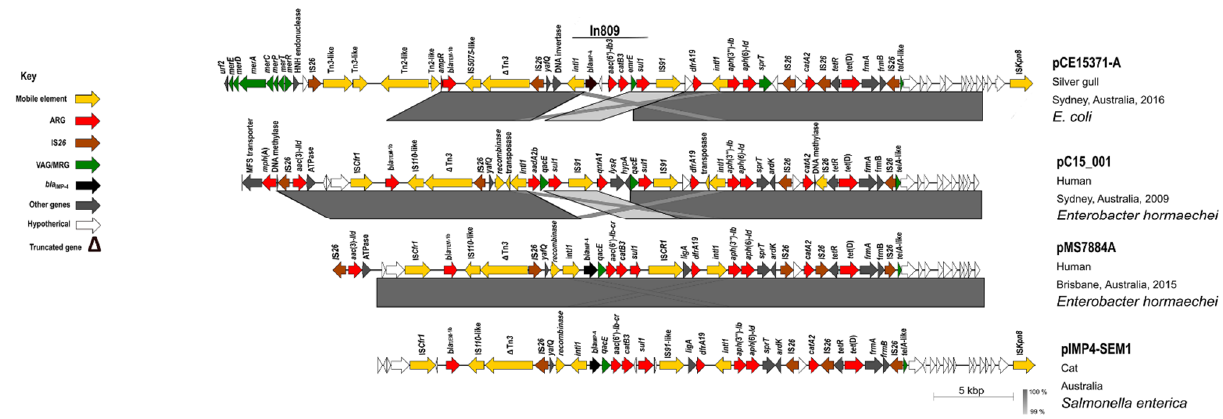
Figure 3. Comparison of IS 26 -composite transposon region and its background within IncHI2-ST1 plasmids from wildlife (pCE1537-A), companion animal (pIMP4-SEM1) and humans (pMS7884a and pC15_001). In the key, ARG: antibiotic- resistance gene and VAG/MRG: virulence associated gene/metal resistance gene.